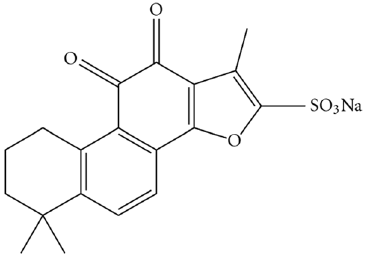
Figure 1. The chemical structure of sodium tanshinone IIA